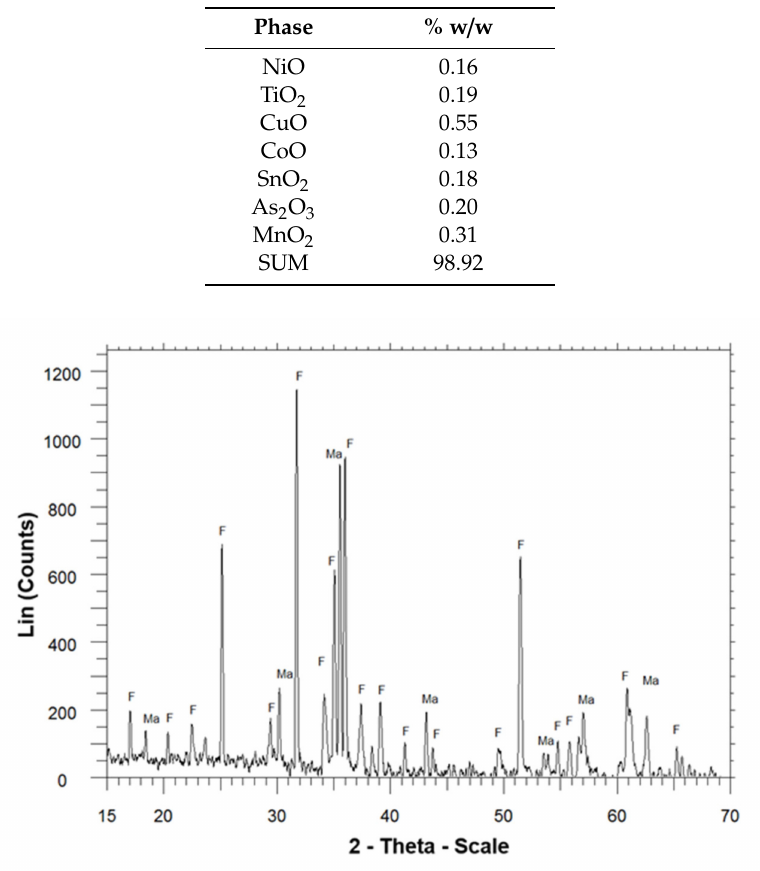
Figure 1. XRD pattern of the copper